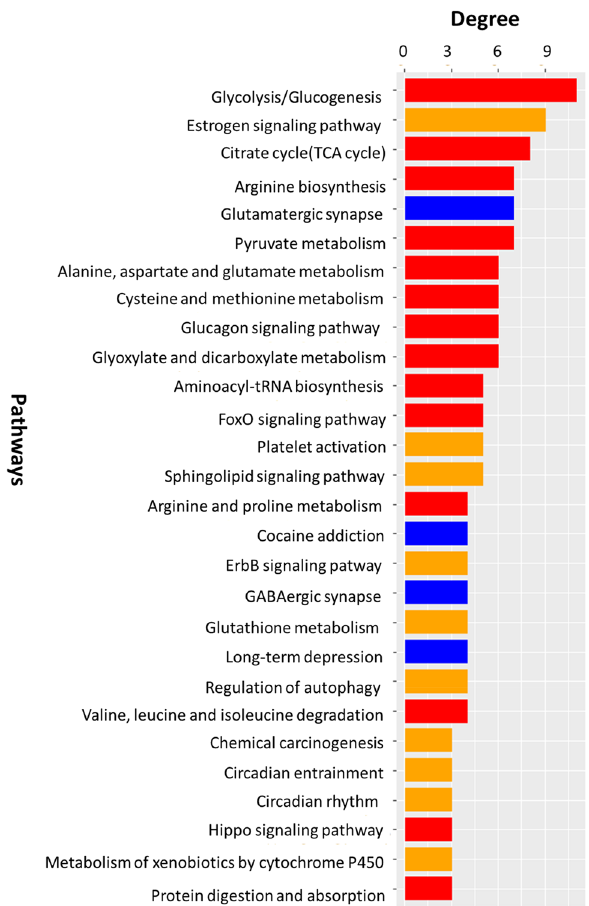
Figure 6. SCZ and BD related pathways predicted in this study (degree ≥ 3, for 28 pathways). Red, yellow and blue bars are pathways related to energy systems, stress response and neuron systems